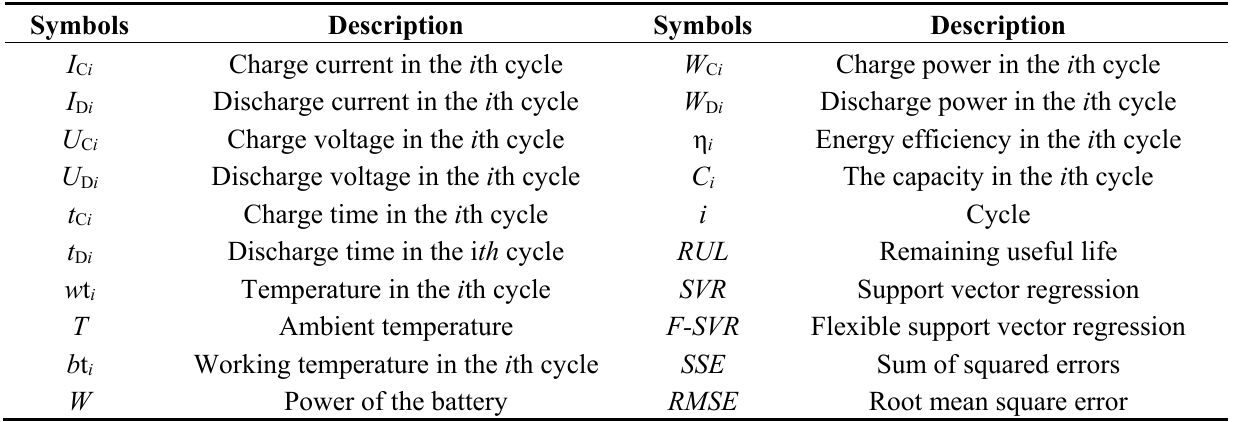
Table 1. Descriptions of symbols and